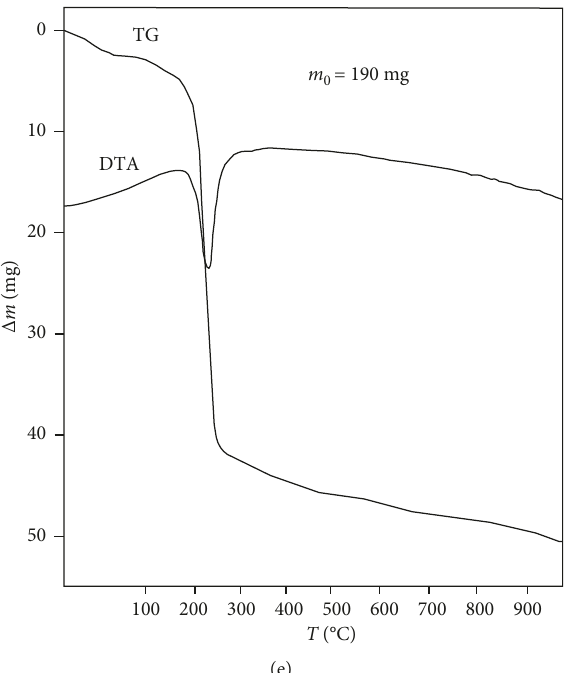
Figure 2: The TG/DTA curves for prepared powders ZnO (a), Zn(OH) Initial mass ( m 0 ) is indicated in the